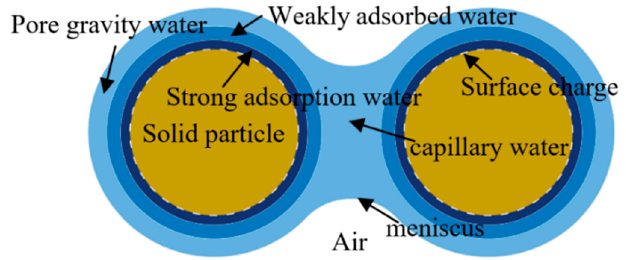
Figure 11. Schematic diagram of pore water distribution around sand